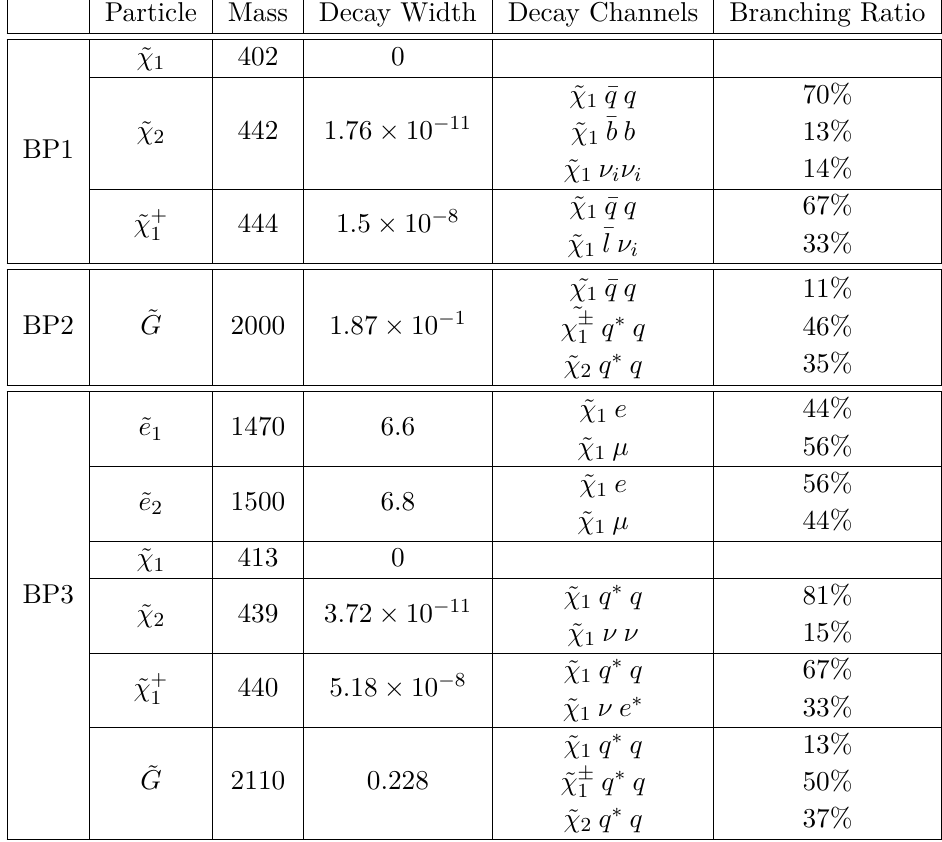
Table 5 . Selected benchmark points (BP) for phenomenology. The first BP exhibits rather light electroweakinos and might represent a challenge for future colliders. The second BP has a rather light gluino, which is already close to the current experimental limits from the LHC collaborations. Finally, the last BP is an example of maximally mixed lightest sleptons. All masses and widths are given in